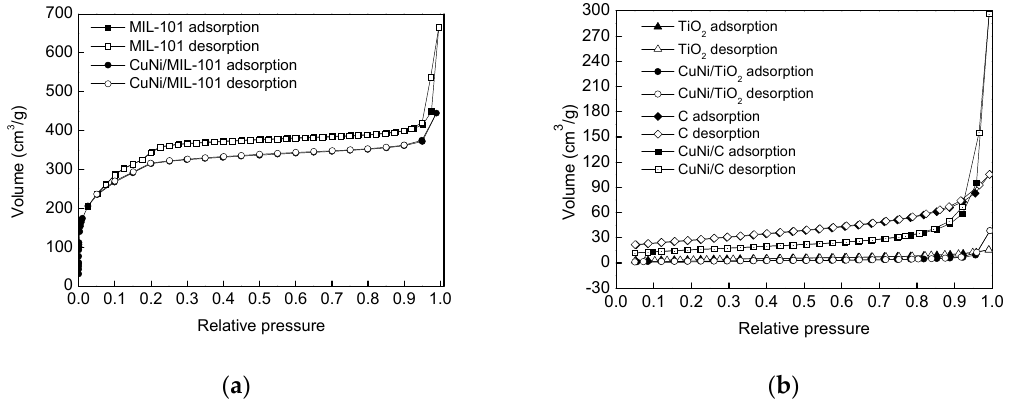
Figure 1. Nitrogen adsorption–desorption isotherms of the samples measured at 77 K: ( a ) The nitrogen–adsorption of MIL-101 and CuNi / MIL-101; ( b ) The nitrogen–adsorption of TiO 2 , CuNi / TiO 2 , C, and CuNi/C.